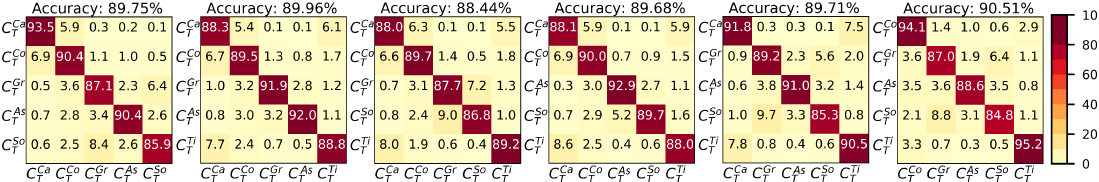
Figure A5. Parallel coordinate chart of quinary classification . The results were obtained with all features set (194 features) for each classifier and for each sensor location.